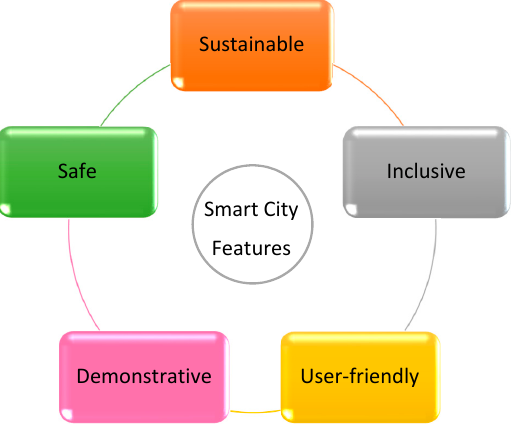
Figure 1. Features of Smart City Vision.